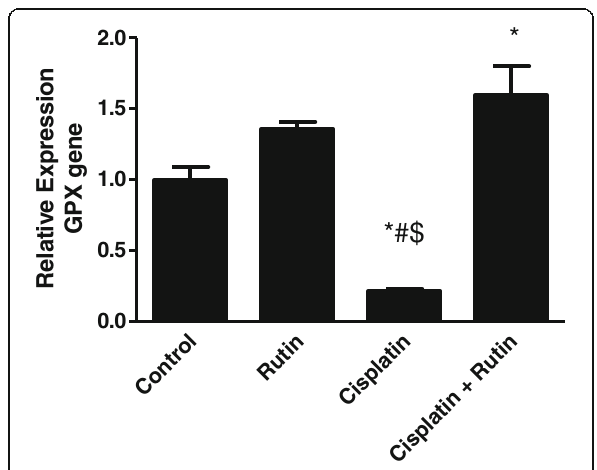
Fig. 2 The Effect of Cisplatin, rutin, and their combination on the expression levels of Glutathione peroxidase in rat brain. Data were presented as mean ± SEM ( n = 10). *, # and $ indicate significant change from control, rutin and CP + rutin, respectively, at P < 0.05